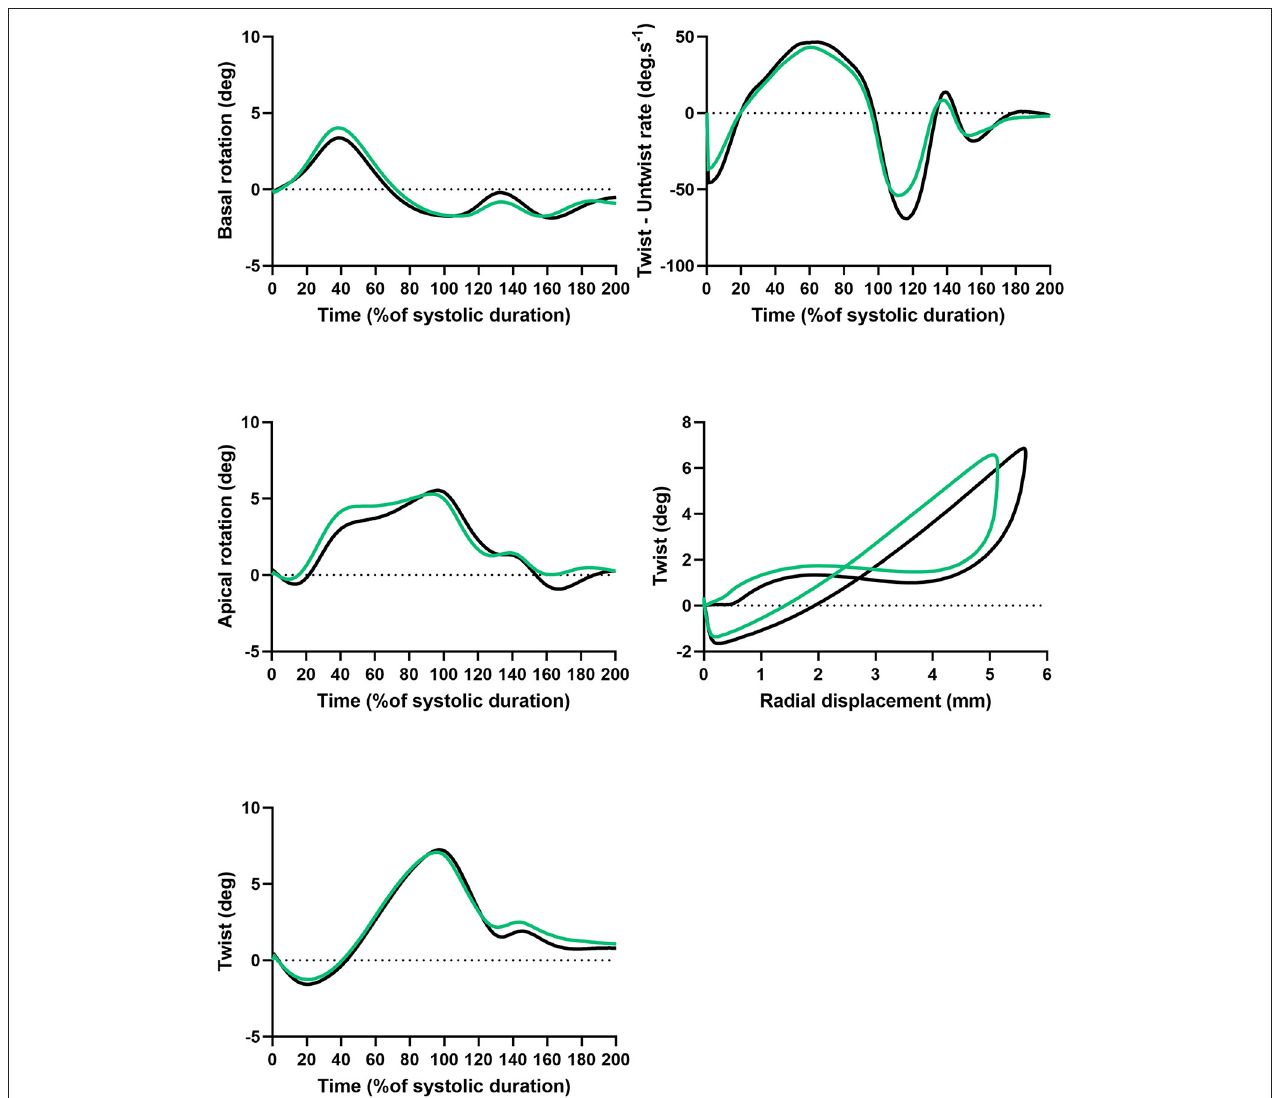
FIGURE 3 | Twist and untwist mechanisms in AN patients and controls. Basal rotation, apical rotation and twist, function of time (%of systolic duration). Twist – untwist rate, function of time (% of systolic duration). Twist function of radial